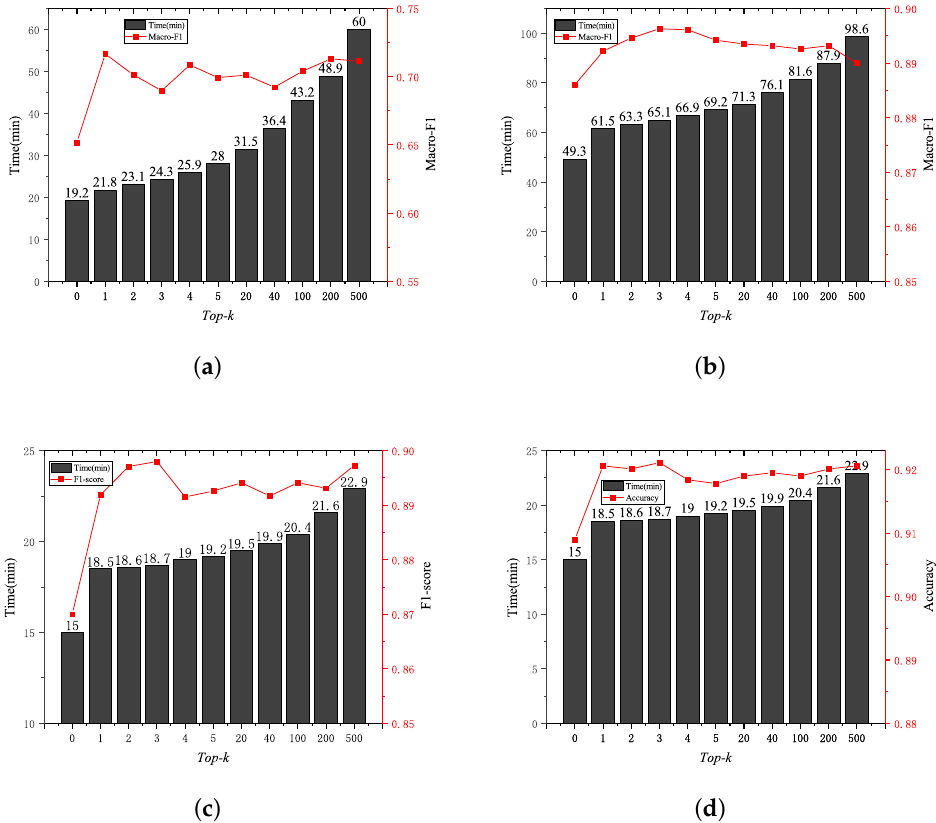
Figure 3. Parameter and time complex analysis of varying the top − k for BERT-JDE. ( a ) NER performance on Sciie. ( b ) NER performance on NCBI-disease. ( c ) CLS performance of F1-score on Intent. ( d ) CLS performance of Accuracy on